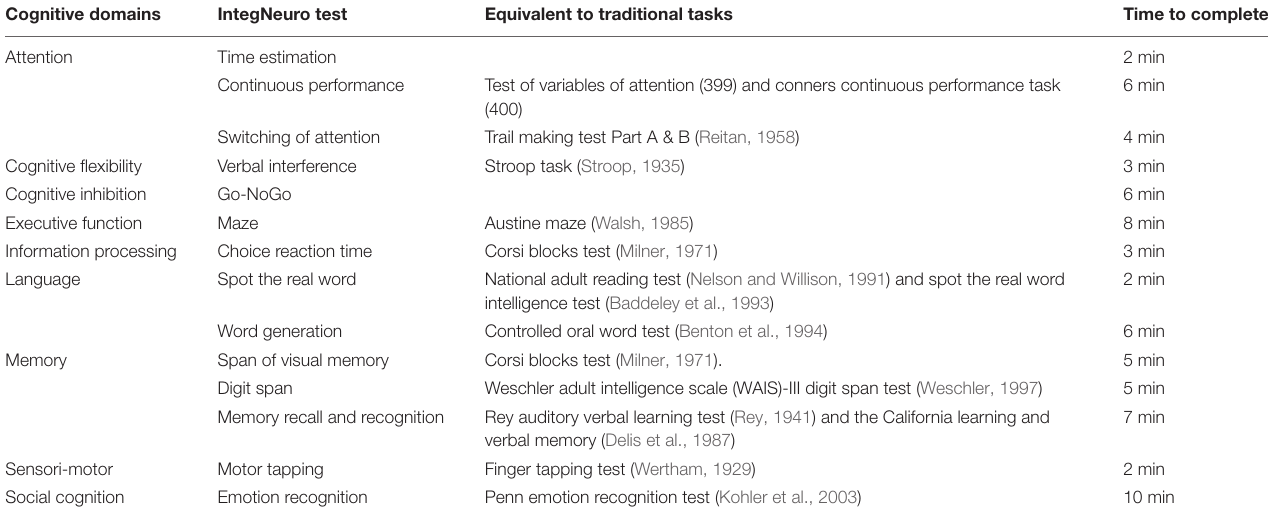
TABLE 1 | Description of neuropsychological measures. Cognitive domains IntegNeuro